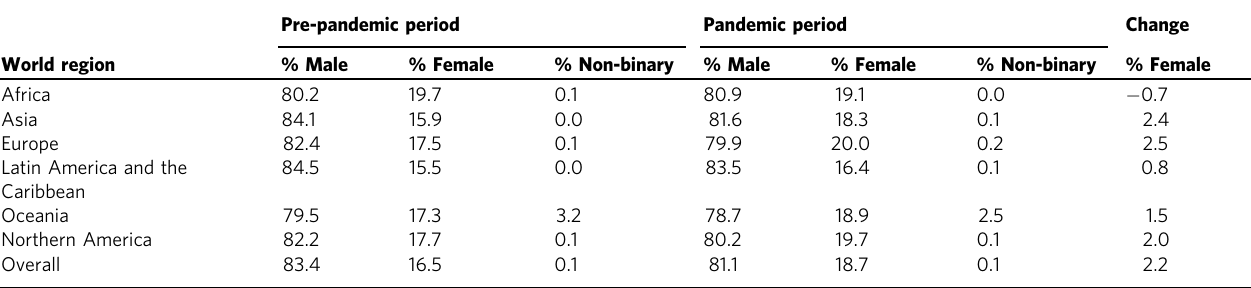
Table 2 Percent of corresponding authorship by gender for pre-pandemic and pandemic periods, by world region.